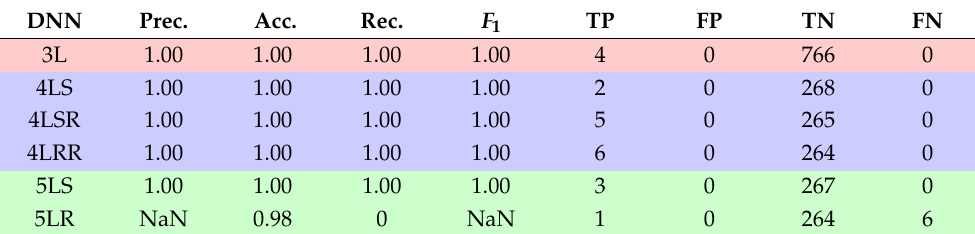
Table 1. Attack 1 detection results without measurement noise.